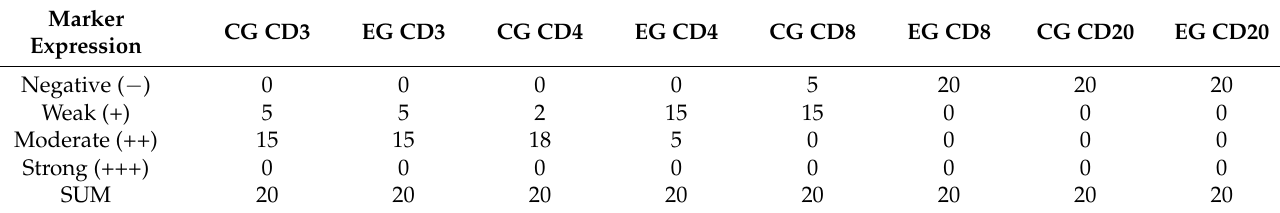
Table 3. CD3, CD4, CD8, and CD20 antigen expression intensity in the decidua basalis.